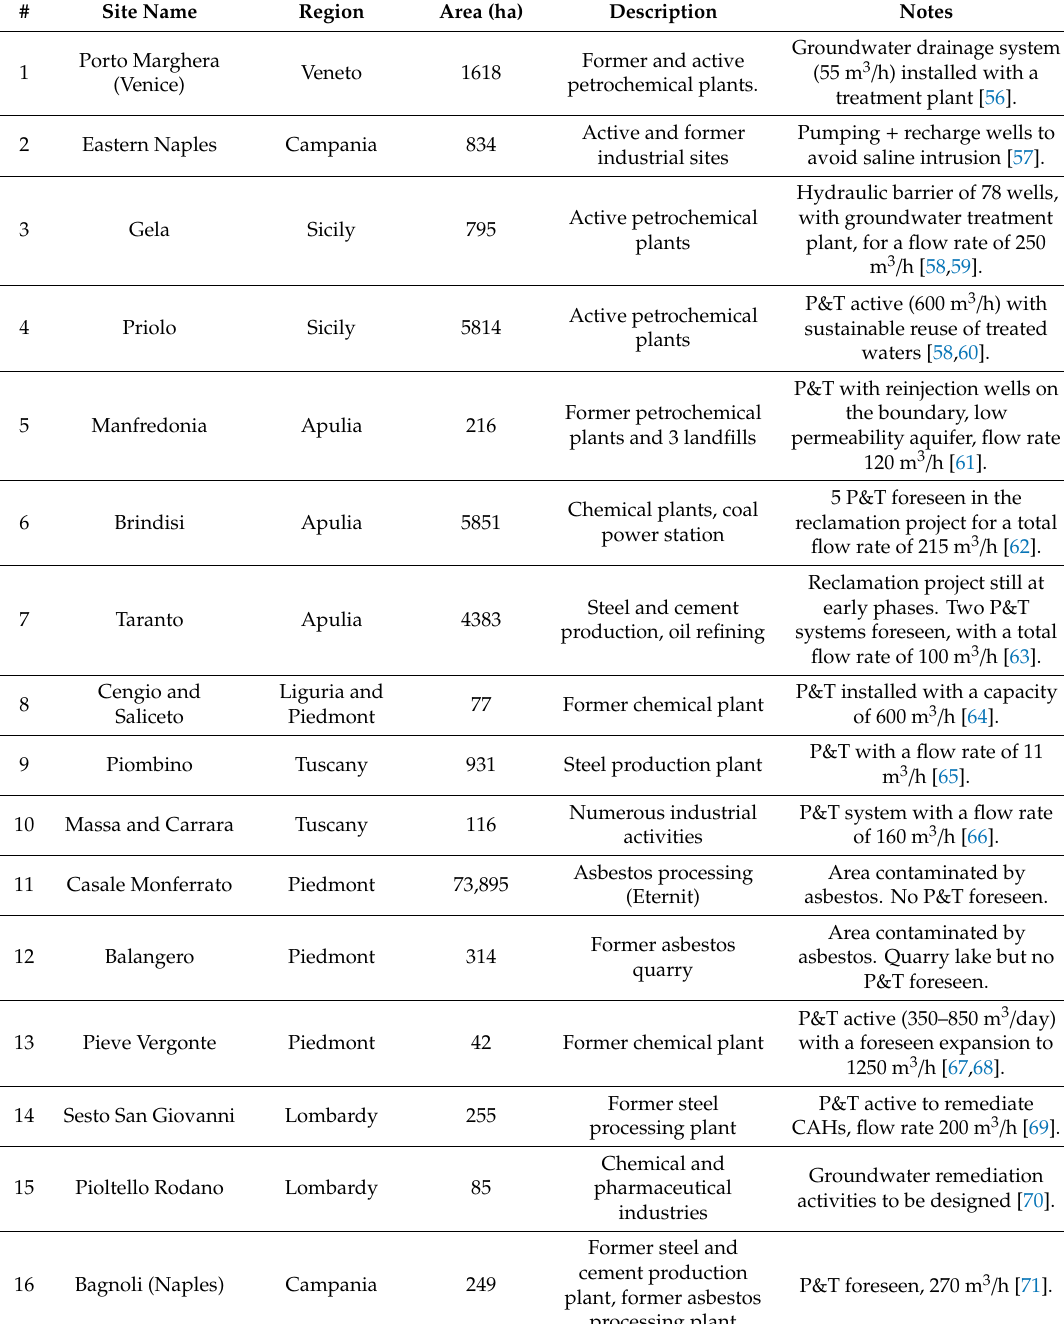
Table A2. Synopsis of Italian national interest contaminated sites